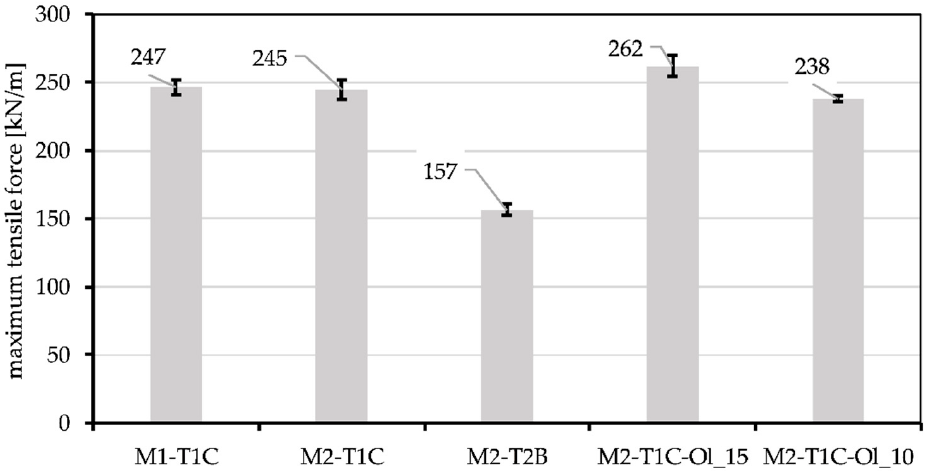
Figure 12. Maximum tensile forces of the composite specimens and the test on the overlapping areas (Ol); mean values of ≥ 4 specimens, with standard deviation indicated.